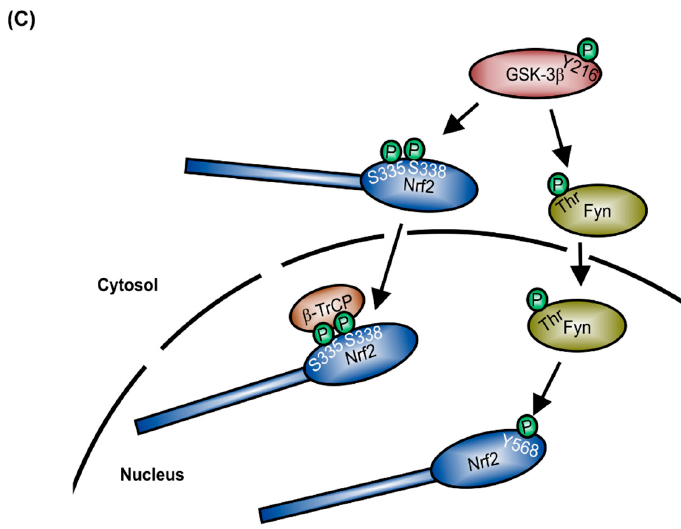
Figure 1. Regulation of Nrf2 expression. ( A ) Domain structure of Nrf2; ( B ) Keap1-dependent degradation of Nrf2 (mod. from [8]), T-bar = inhibition of Nrf2 degradation, consequently blocking Keap1 release; ( C ) Keap1-independent mechanism of Nrf2 degradation.